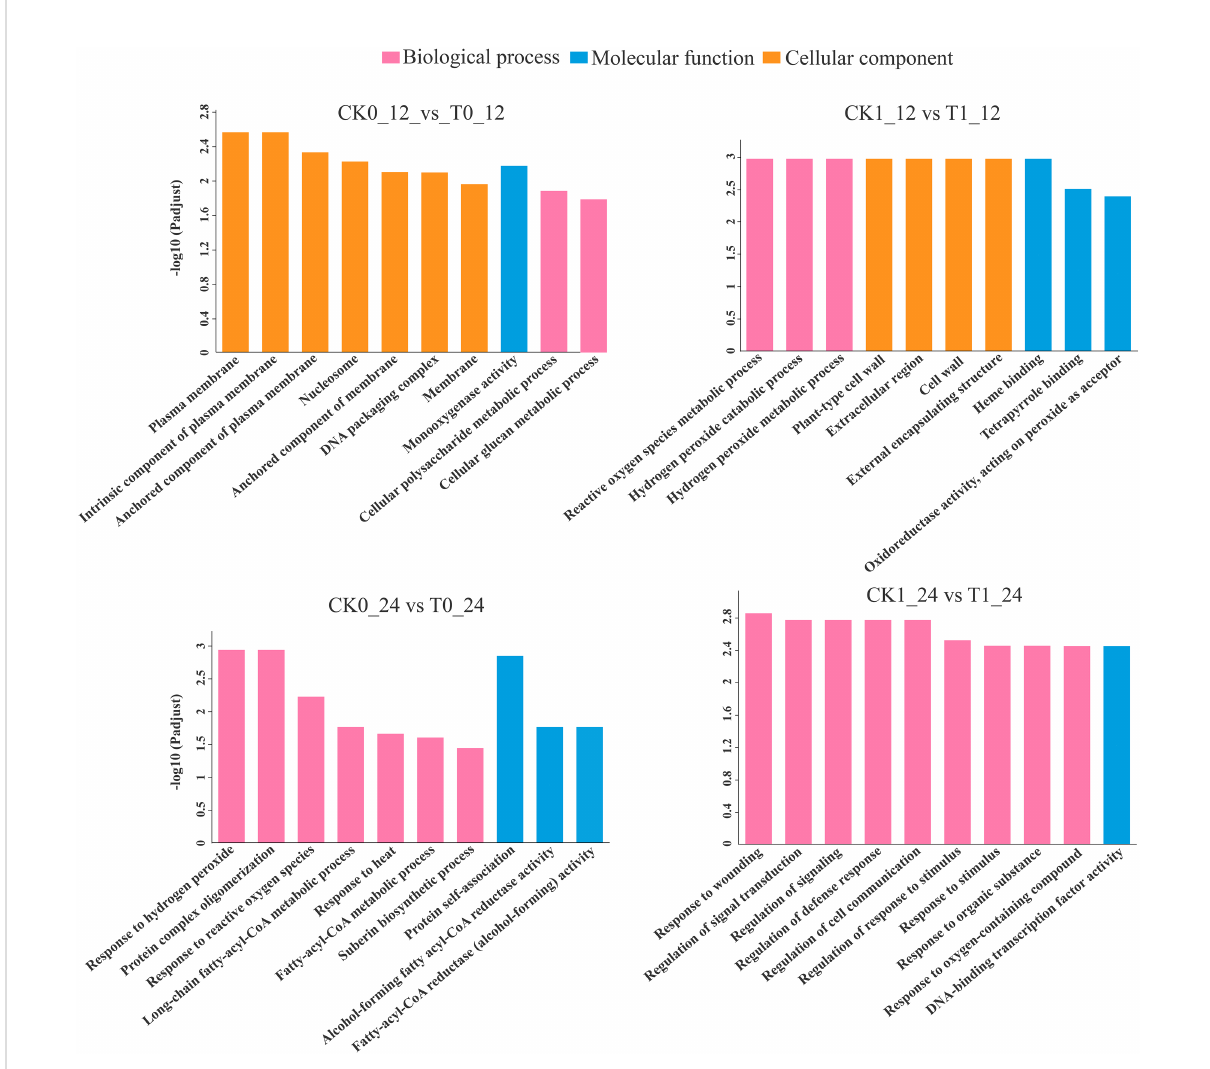
FIGURE 5 GO enrichment analysis of DEGs. p -adjust < 0.05 was considered to be signi fi cantly